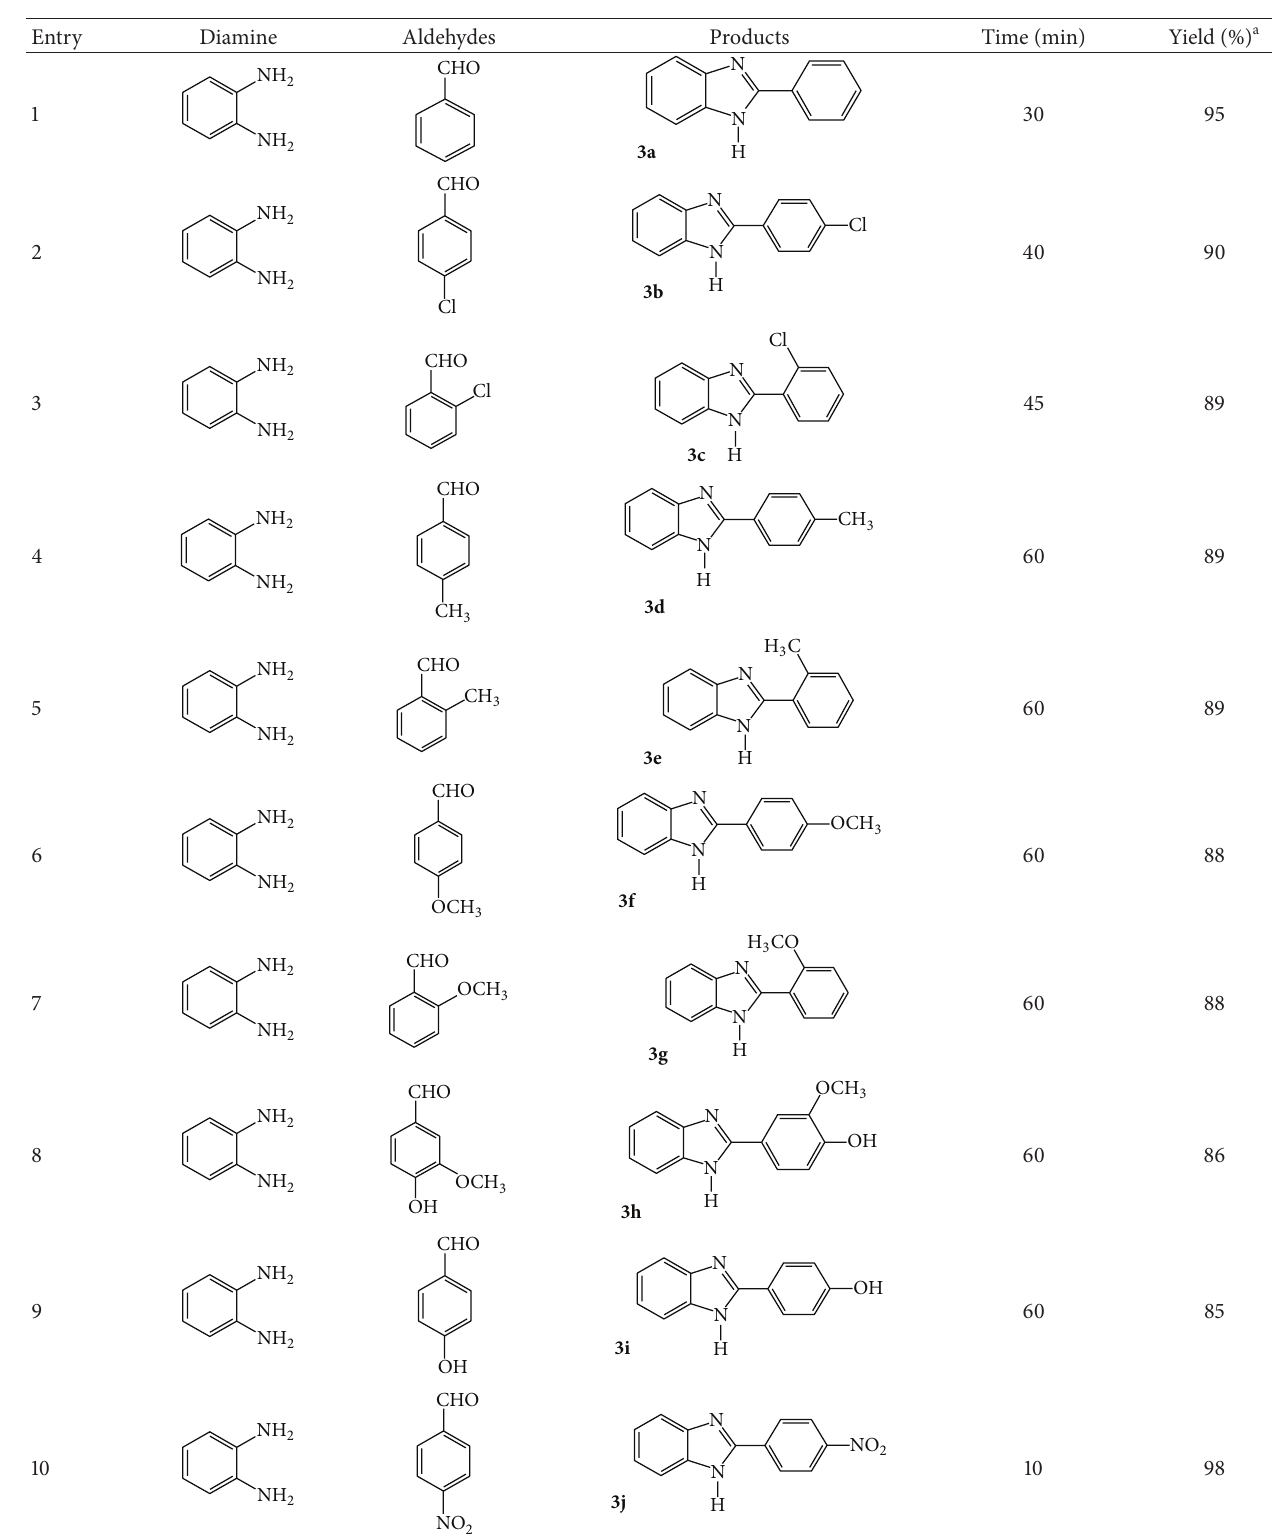
Table 2: Synthesis of benzimidazole 3a–o by using boric acid in